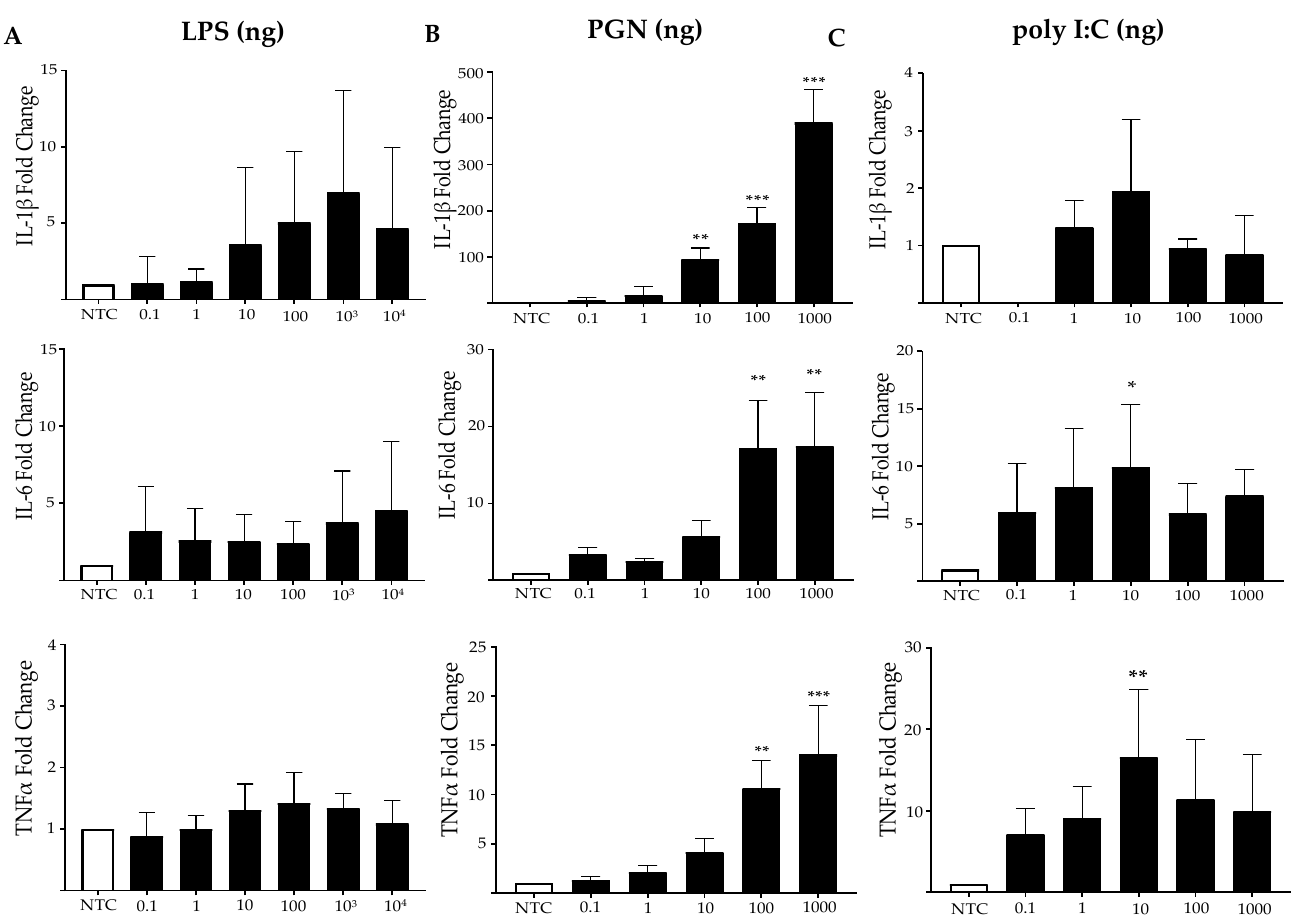
Figure 1. PAMP stimulation exerts inflammatory response in MCs . MES SV40 cells (1.5 × 10 6 ) were stimulated in 2 mL of medium containing different amounts of ( A ) LPS; ( B ) PGN; ( C ) poly I:C for 6 h, and the mRNA expressions of IL-1 β , IL-6 and TNF α were measured. RT-PCR results are expressed as a fold change relative to Actb, and the respective non-stimulated control (NTC). Results are from at least 3 independent experiments and are listed as mean ± SD. * p < 0.05, ** p < 0.01, *** p < 0.001, one-way ANOVA followed by Dunnett ´ s